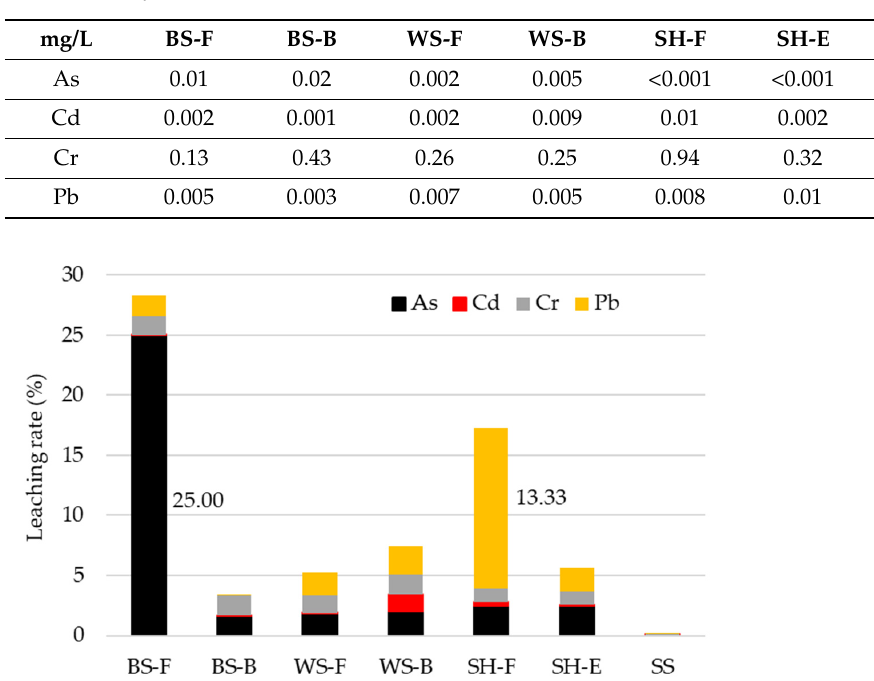
Table 7. Heavy metals leached out of ABAs.